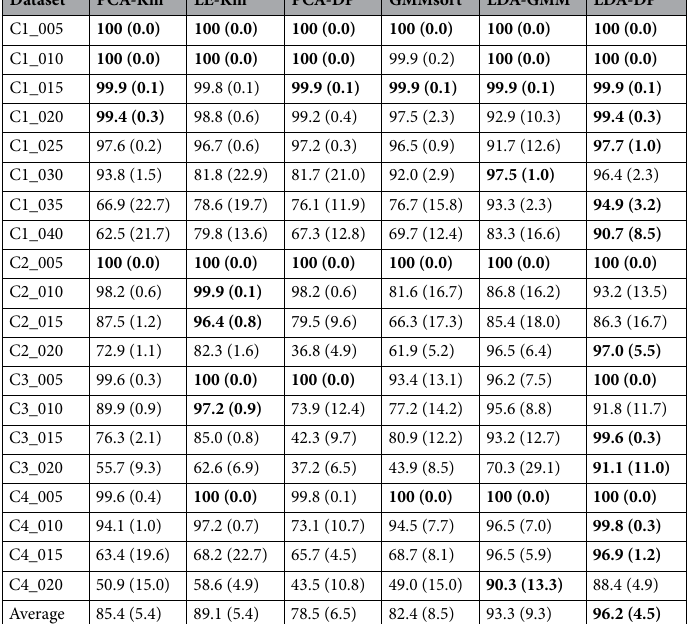
Table 1. Average sorting accuracy percentage on the Dataset A (simulated dataset wave _ clus ) (with no overlapping spikes) for 6 algorithms. The standard deviation of the accuracy is in parenthesis. The bold number represents the best performance in each testing